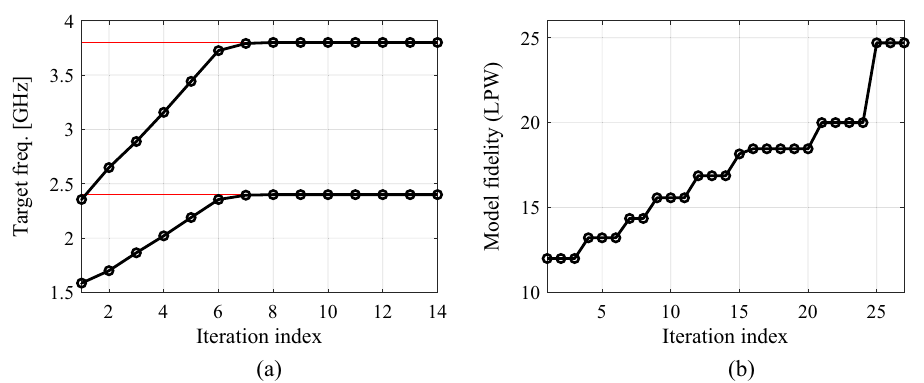
Figure 14. Dual-band power divider: ( a ) history of the target operating frequency (horizontal lines mark the initial targets); ( b ) evolution of the model